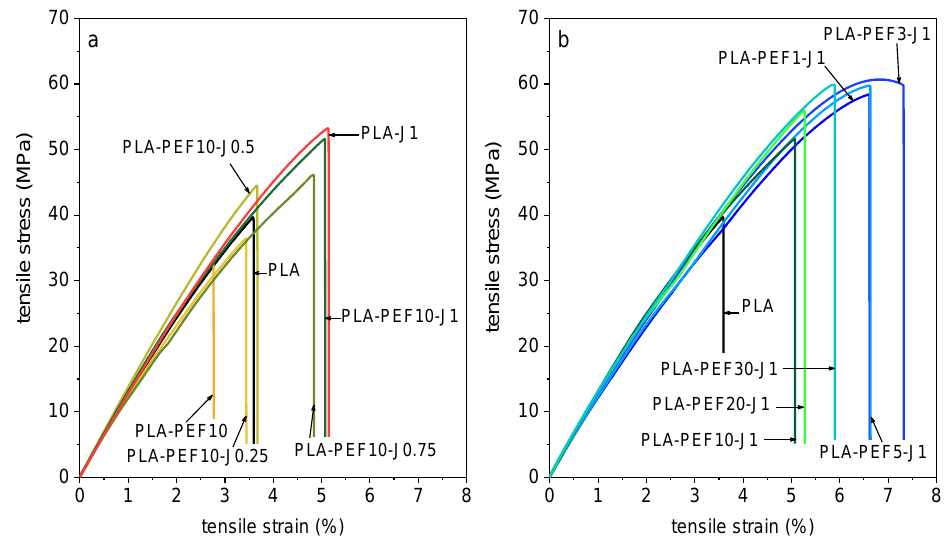
Figure 8. Representative stress–strain curves of some selected compositions. ( a ) PLA, PLA-PEF10-Jx (x = 0.25–1) and PLA-J1; ( b ) PLA and PLA-PEFx-J1 (x = 1 – 30).